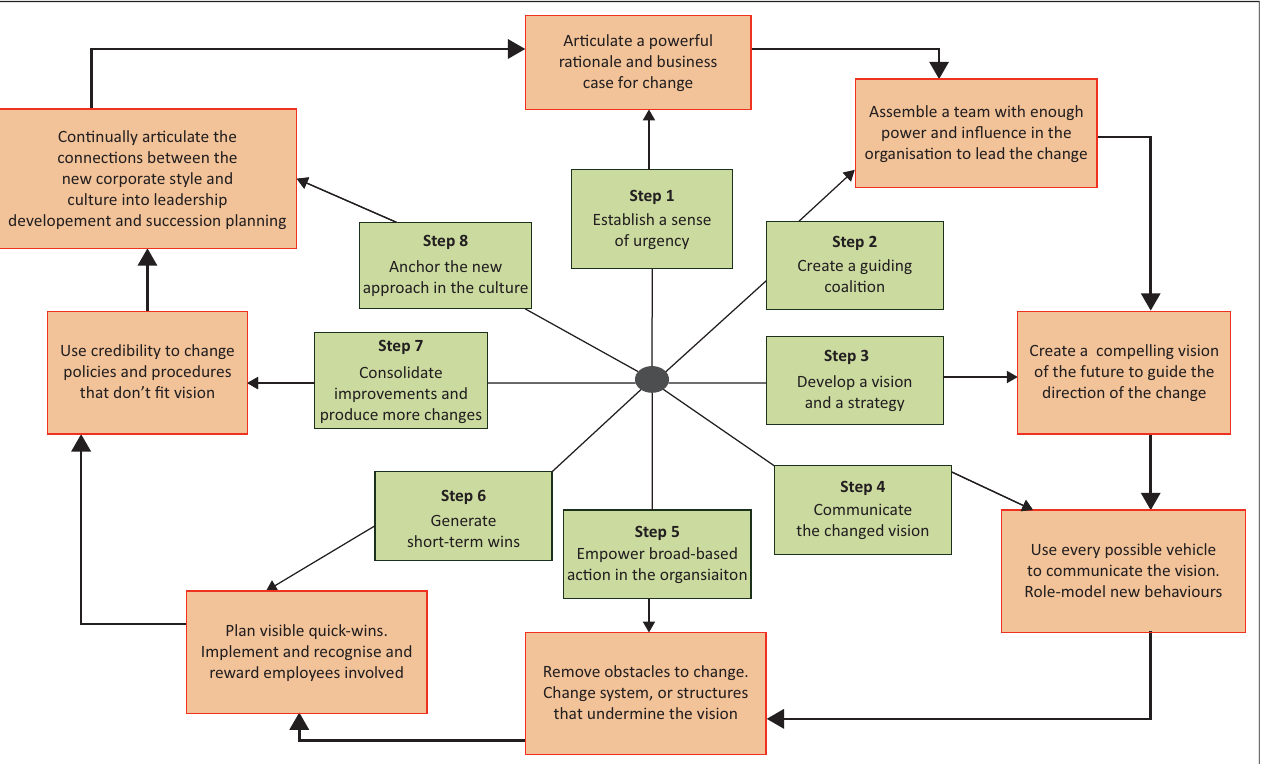
FIGURE 2: Eight-step model for managing